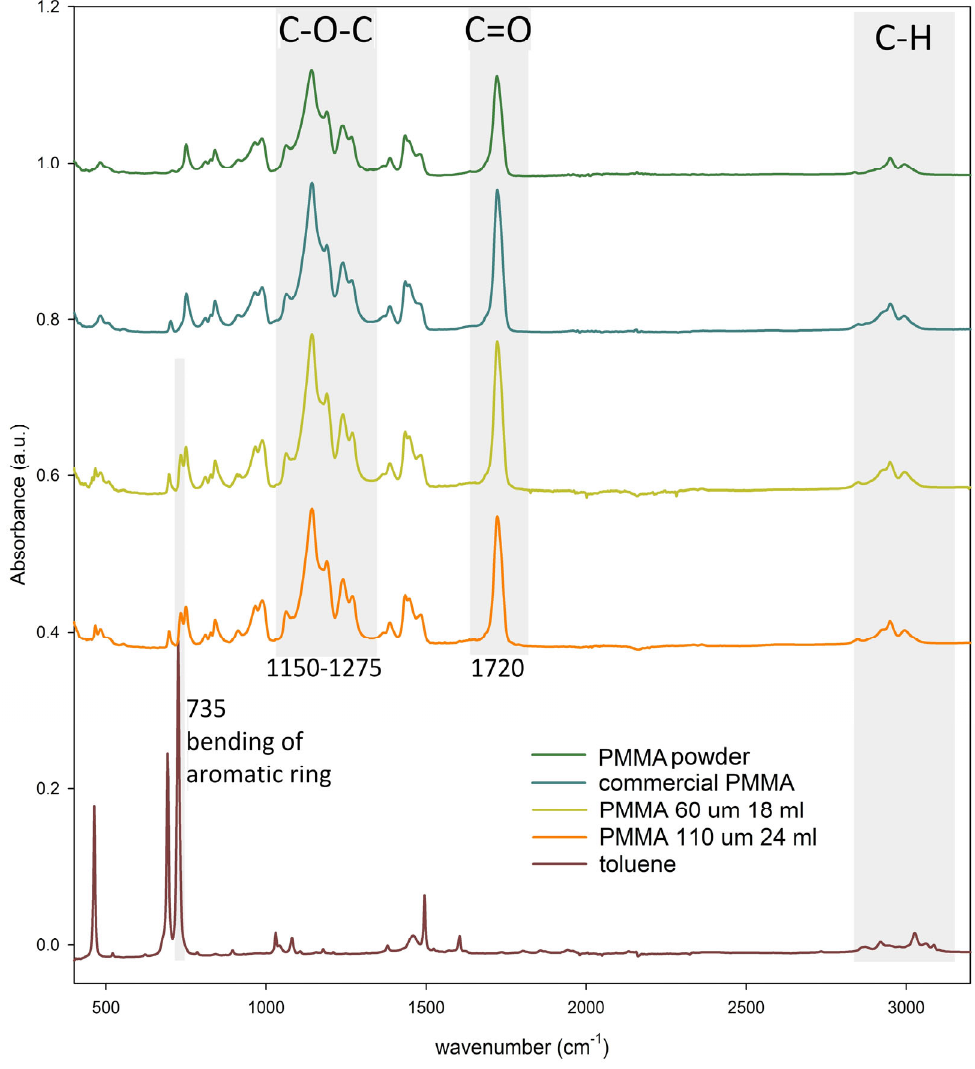
Figure 4. FTIR spectra for PMMA powder, commercial, and as ‐ cast foils. Figure 5. FTIR spectra for PMMA powder, commercial, and as-cast